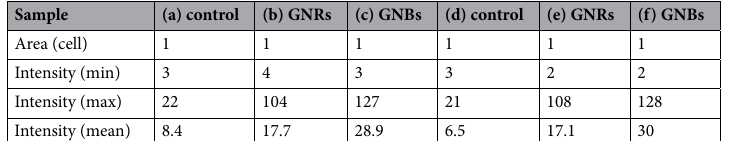
Table 2. The fluorescence brightness of the selected cell.